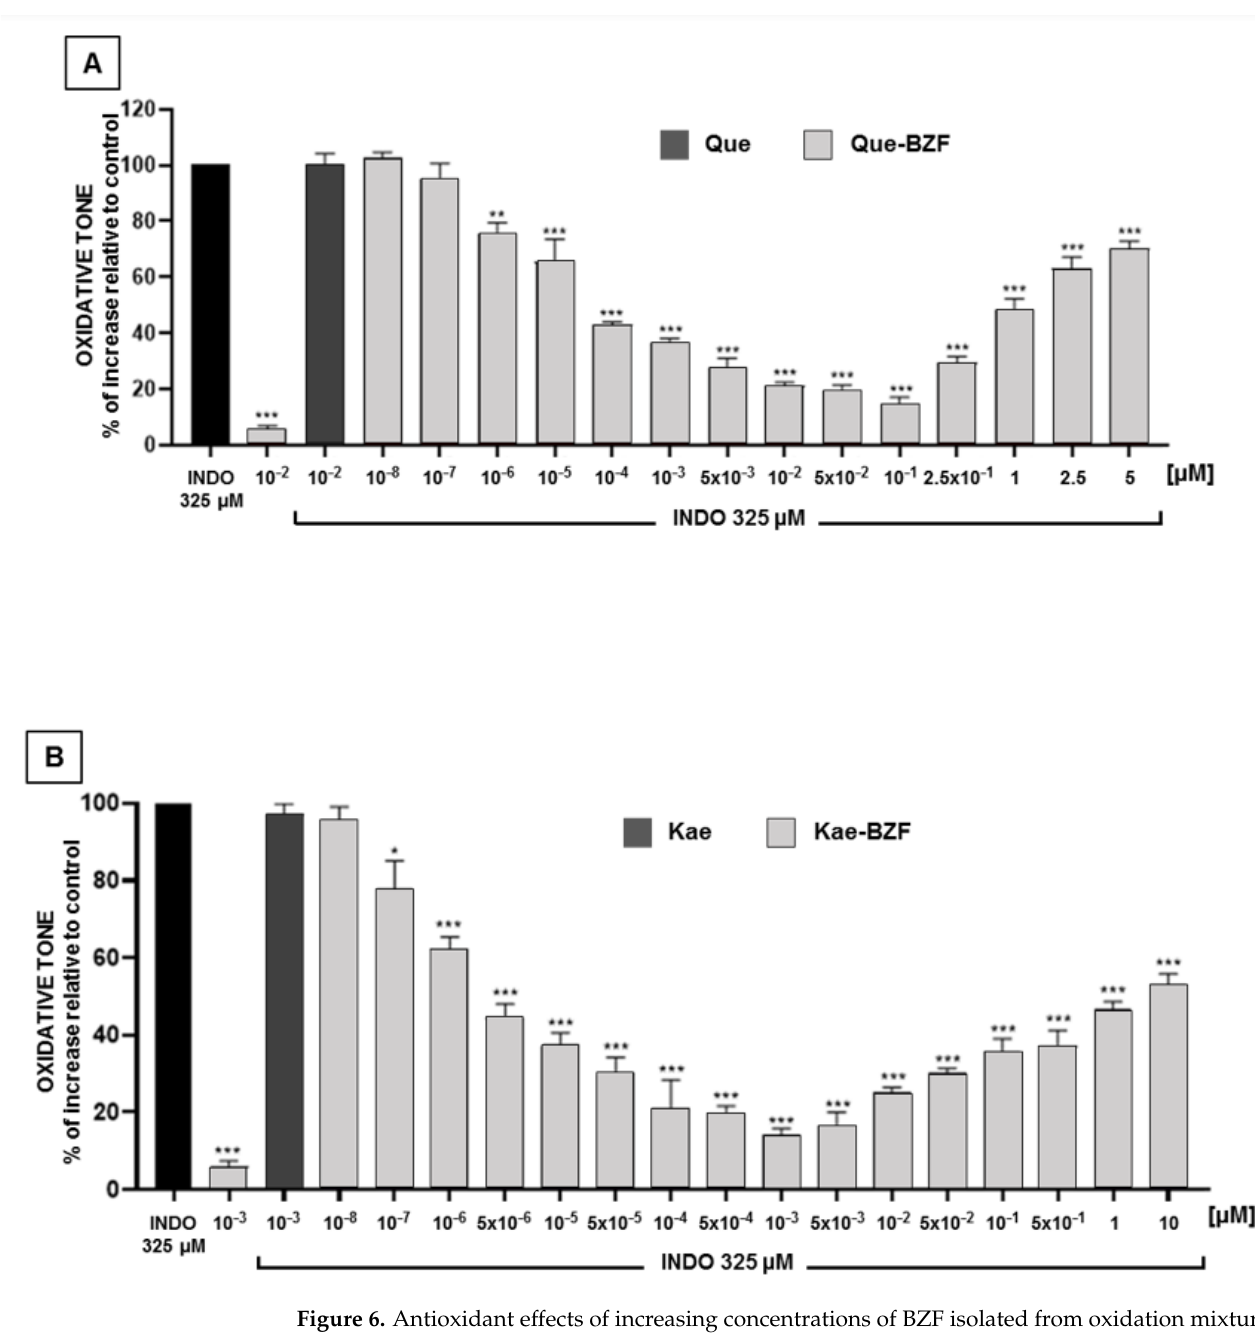
Figure 6. Antioxidant effects of increasing concentrations of BZF isolated from oxidation mixtures of ( A ) quercetin and ( B ) kaempferol, against the increase in intracellular oxidative tone induced by indomethacin. Significant differences: * p < 0.05, ** p < 0.01, and *** p < 0.001 relative to indomethacin- treated cells.